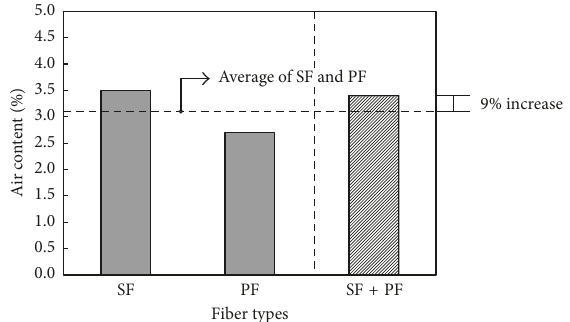
Figure 3: Influence of fiber combination on air content of concrete mixtures (the dotted line expresses the average value of SF and PF).